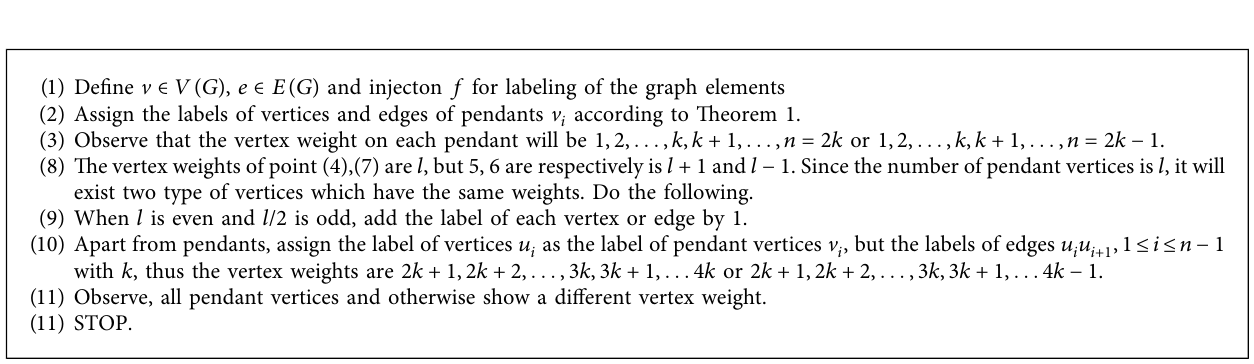
A LGORITHM 1: The vertices’ and edges’ labels.